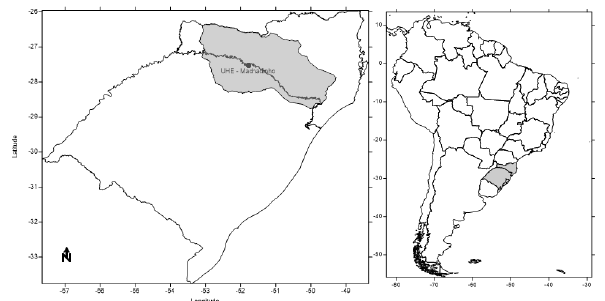
Figure 1. Study area